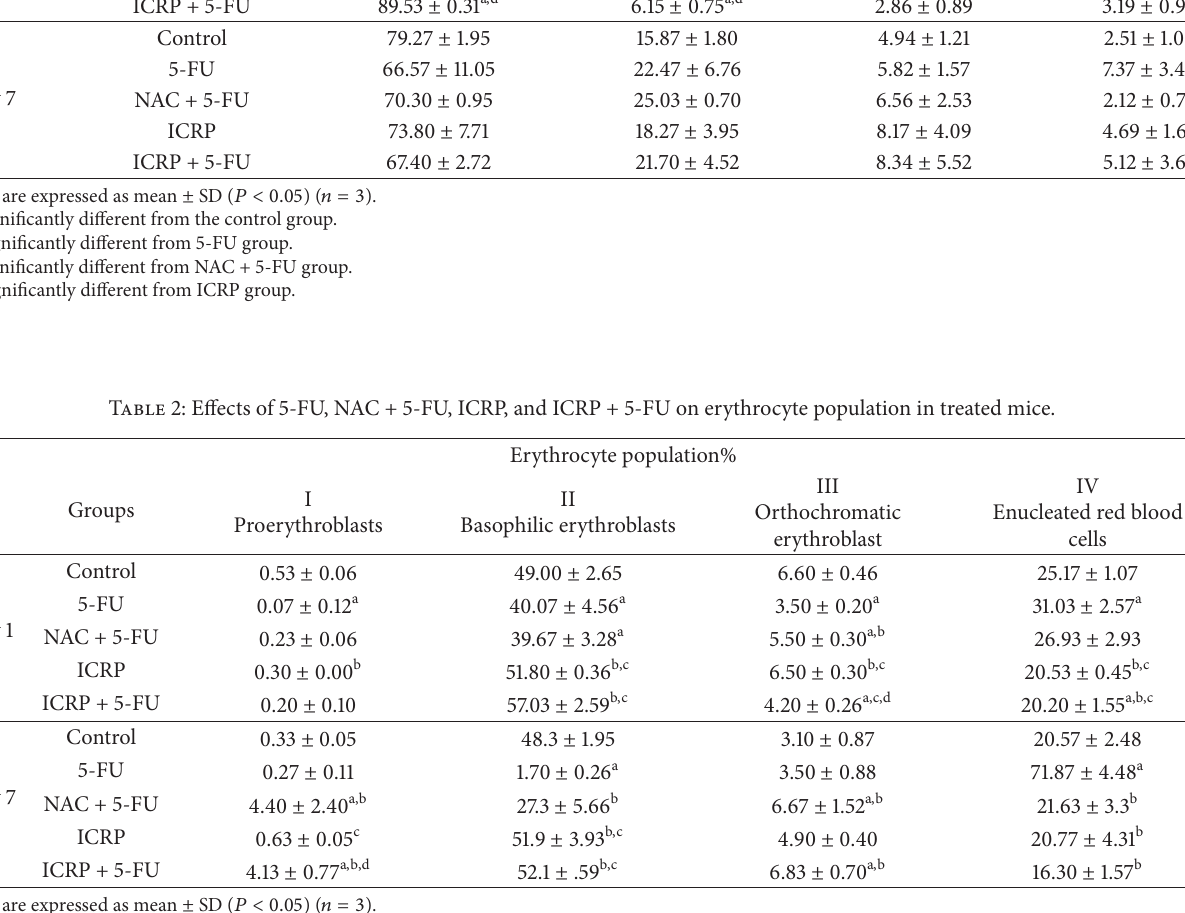
Table 1: Effects of 5-FU, NAC + 5-FU, ICRP, and ICRP + 5-FU treatments on cell cycle phases in mice.